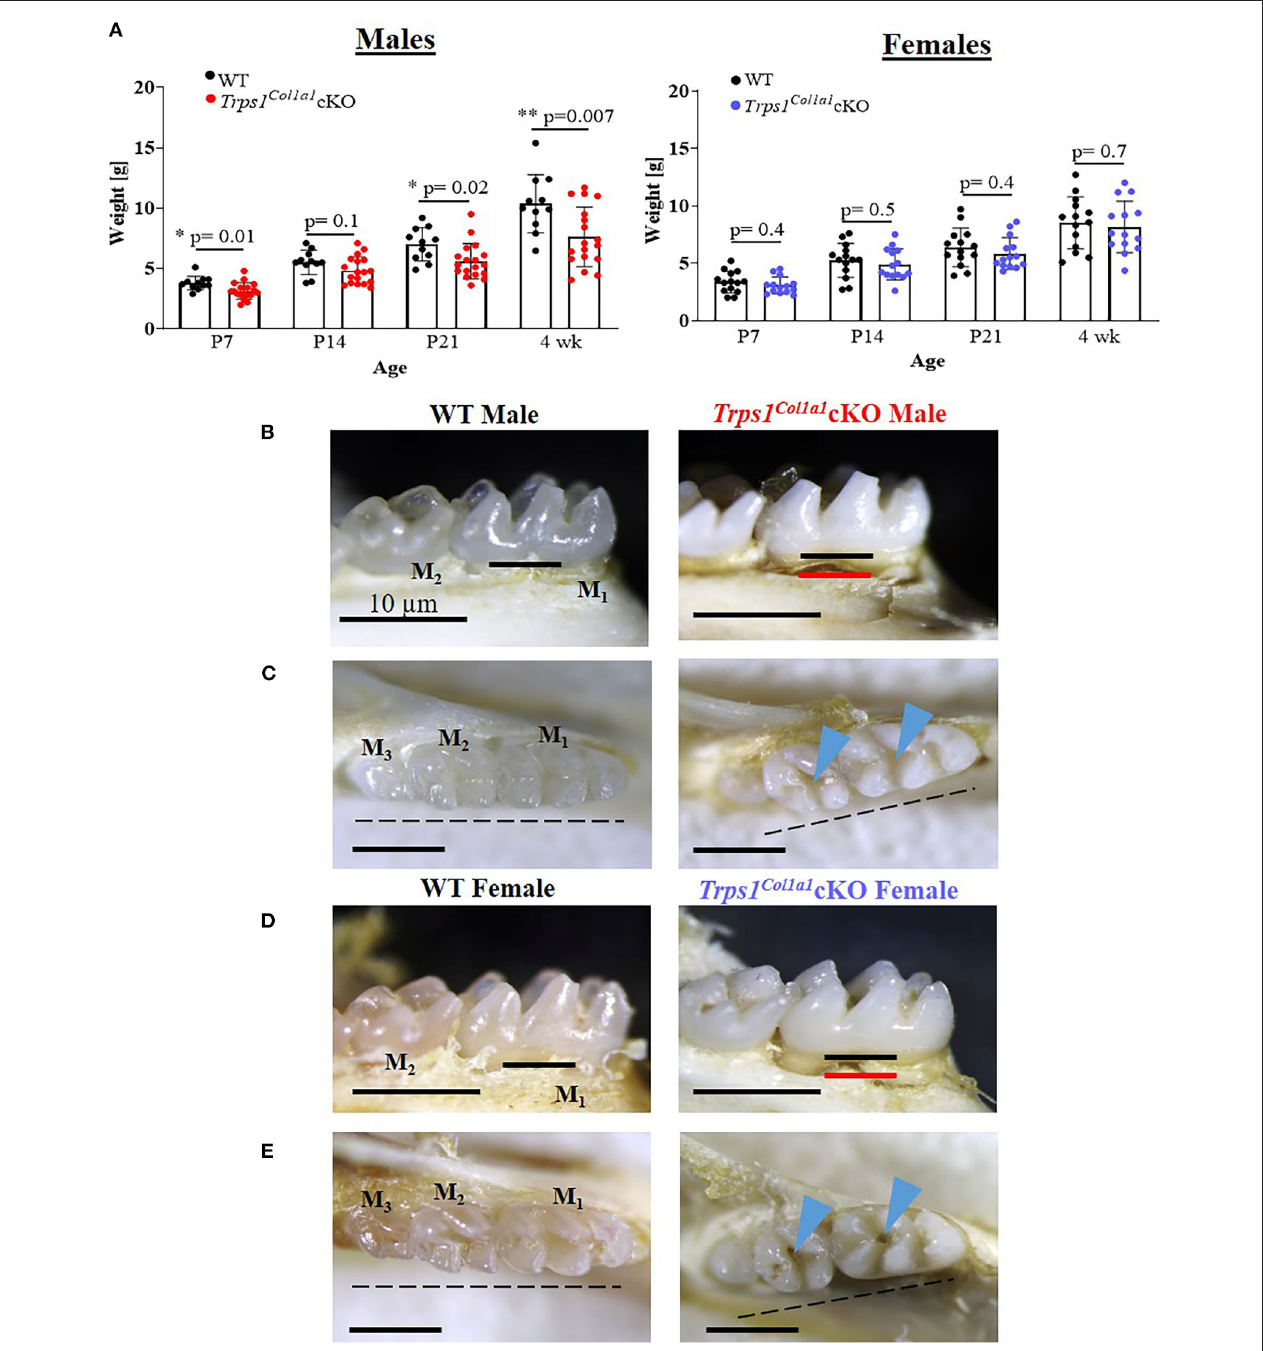
FIGURE 2 | Gross assessment of Trps1 Col1a1 cKO mice and appearance of teeth. (A) Body weight of WT and Trps1 Col1a1 cKO mice (males, N = 11 and N = 18, respectively; females, N = 14 and N = 14, respectively) showing mild growth retardation of Trps1 Col1a1 cKO males. Data are shown as individual weight of each mouse (represented by dots) along with mean values ± SD; * p < 0.05 and ** p < 0.01. (B,D) Lingual view of mandibular molars (M 1 and M 2 ) showing “chalky” white appearance and exposed root surfaces in 4 wk old Trps1 Col1a1 cKO male and female mice. The black line represents the bone level at baseline, and the red line represents the bone level in the Trps1 Col1a1 cKO. (C,E) Occlusal view of mandibular molars (M 1 , M 2 , M 3 ) showing deep molar pits (blue arrowheads) and misaligned teeth (dotted line) in 4 wk old Trps1 Col1a1 cKO males and females. Scale bar = 10 µ m.